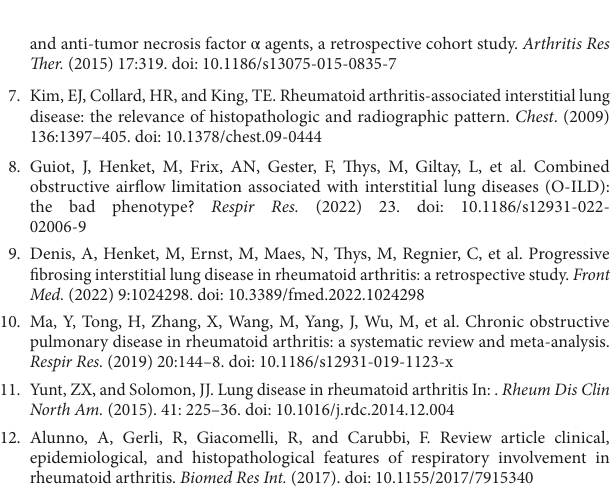
SUPPLEMENTARY FIGURE S1 Comparison of time-dependent AUC(t) for univariate or multivariate models for survivval